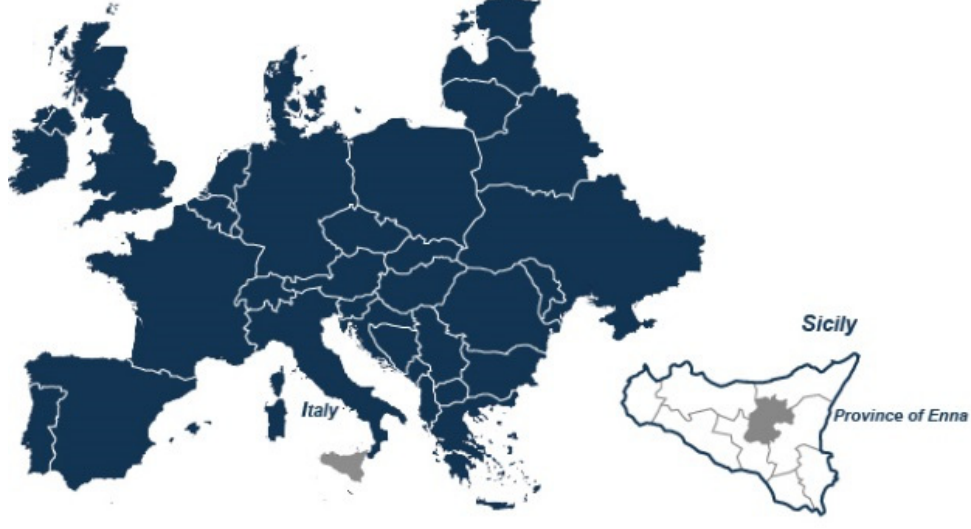
Figure 1. Geographic location of the Province of Enna.